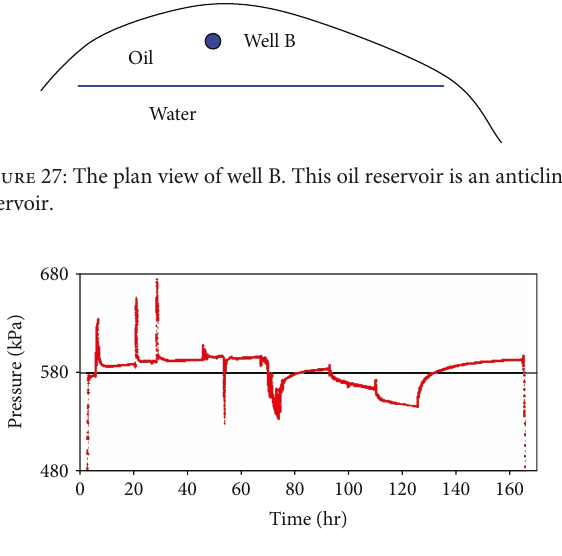
Figure 28: The test history of well B. The last DD and last BU are selected for analysis.